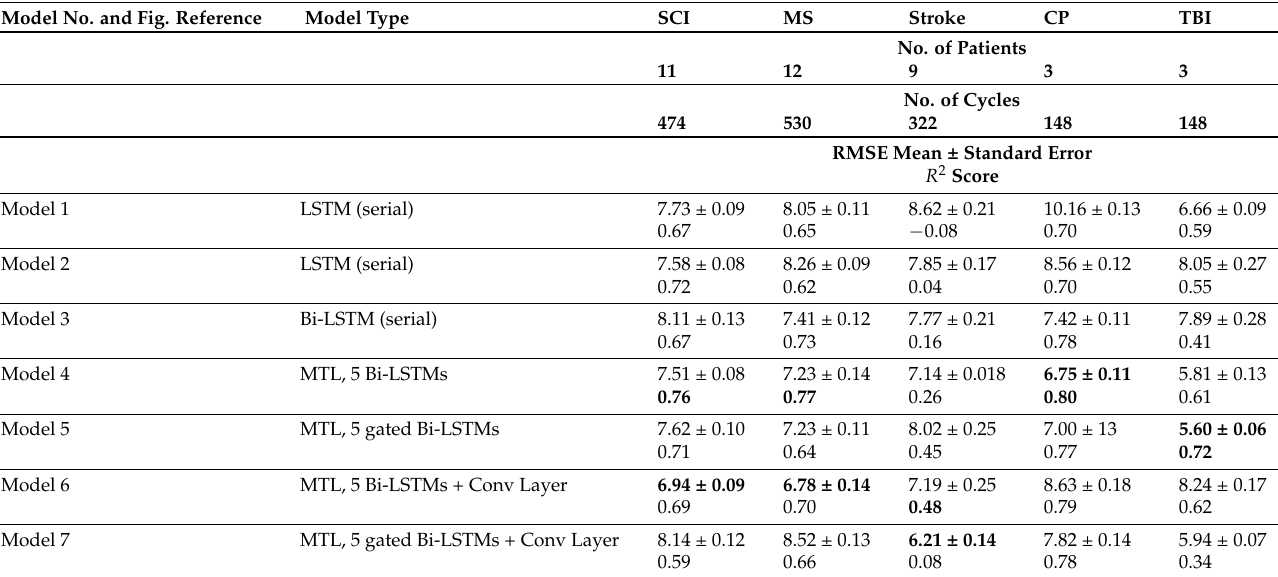
Table 5. Performance of different models in the prediction of post-treatment knee gait with respect to different diseases.